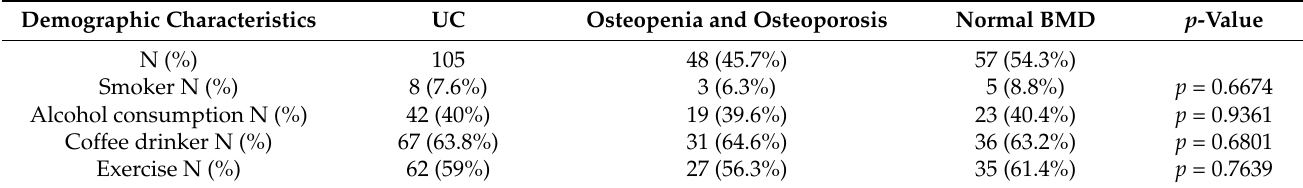
Table 7. The lifestyle parameters of the studied UC patients with respect to osteoporosis and osteopenia. Demographic Characteristics